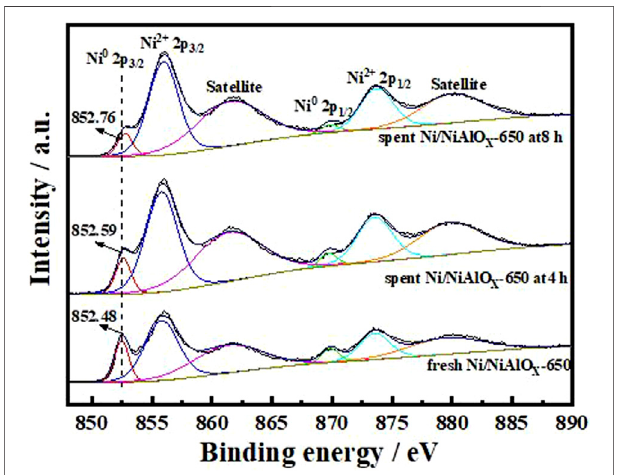
FIGURE 6 | CO-FTIR of Ni/NiAlO x -650 catalysts with different reaction times in the PHE hydrogenation